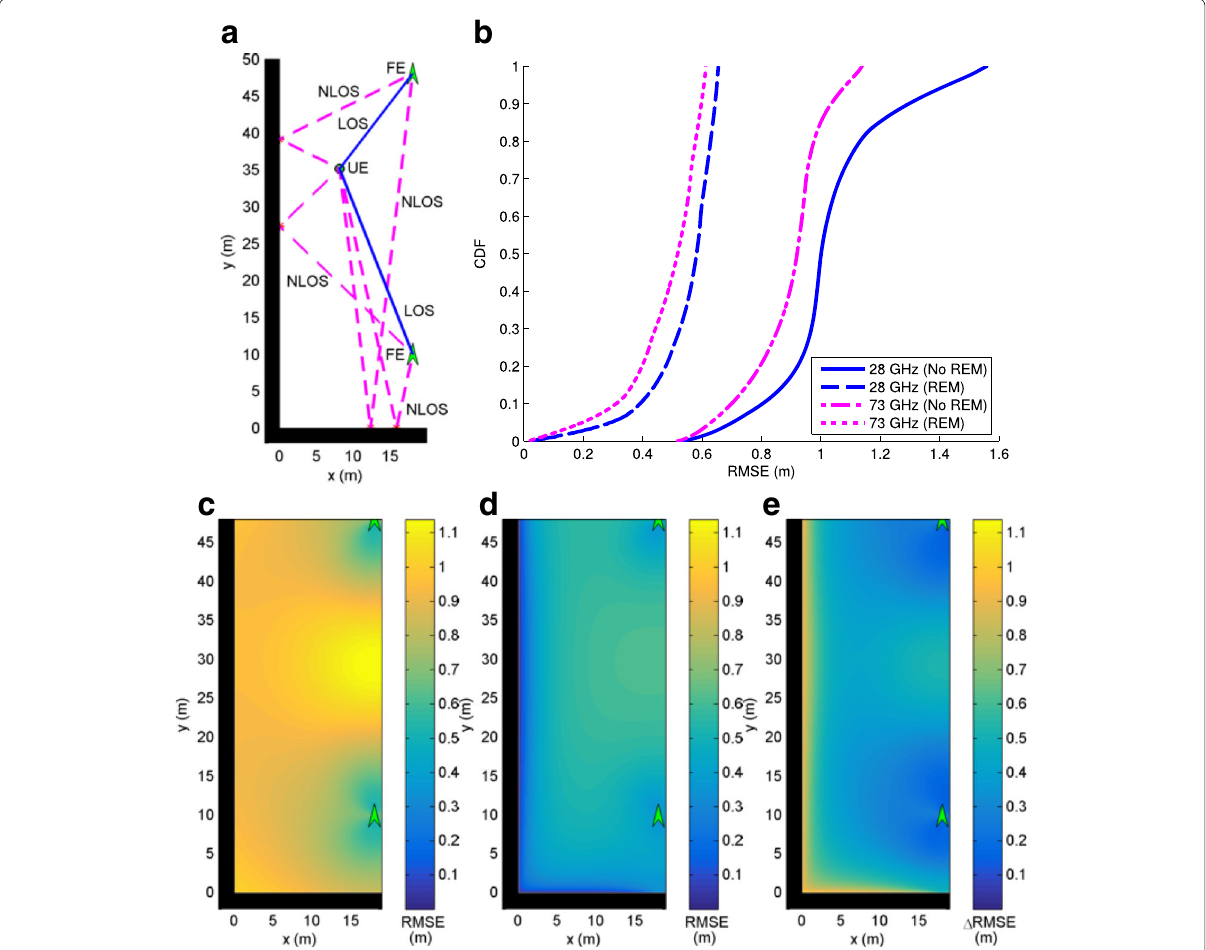
Fig. 9 a Urban corner with two FEs, two LOS paths, and two NLOS paths. b CDF of RMSE. c RMSE at 73 GHz without REM. d RMSE at 73 GHz with REM. e Improvement in RMSE with REM at 73